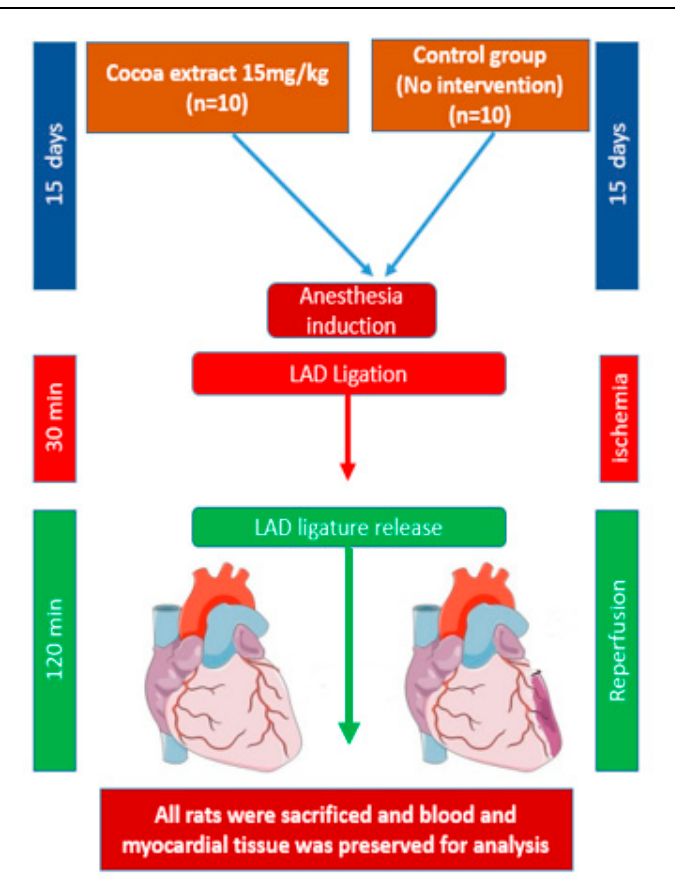
Figure 1. Schematic experimental design.